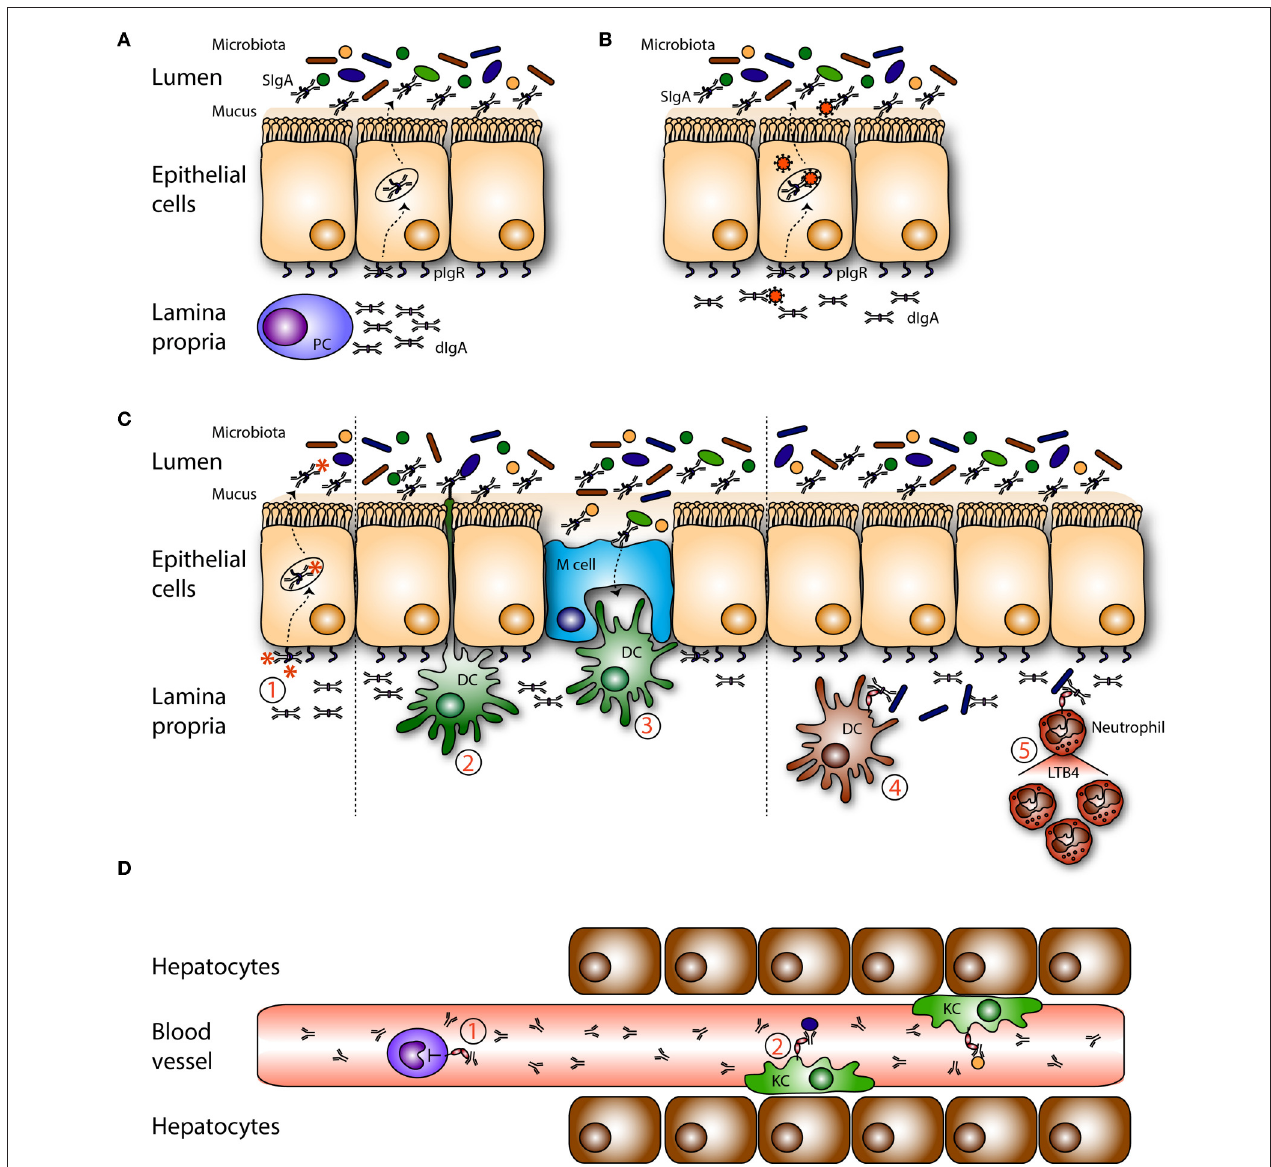
FIGURE 2 | Roles of mucosal IgA in homeostasis. (A) Dimeric IgA (dIgA) is produced by local plasma cells (PC) in the lamina propria. Dimeric IgA is transported to the intestinal lumen by binding to the polymeric immunoglobulin receptor (pIgR) present on epithelial cells. In the lumen it is released as secretory IgA (SIgA) where it can coat (commensal) bacteria. (B) On route dIgA can bind, neutralize and eliminate viruses. (C) (1) Infiltrated antigens and pathogens are opsonized by dIgA and transported back into the lumen. Sub epithelial dendritic cells (DCs) can (2) sample antigens or (3) take up SIgA-coated pathogens that enter via microfold cells (M cells). Pathogens in the lamina propria are coated with dIgA after which this immune complex is taken up by Fc α RI- expressing (4) DCs, and (5) neutrophils. In response neutrophils secrete leukotriene B4 (LTB4), hereby attracting more neutrophils, which will clear the infection. (D) Serum IgA is (1) capable of inhibiting (unwanted) pro inflammatory responses in the circulation via ITAMi signaling in monocytes. (2) IgA-opsonized bacteria which have leaked into the circulation are taken up by Fc α RI-expressing Kupffer cells (KC) in the